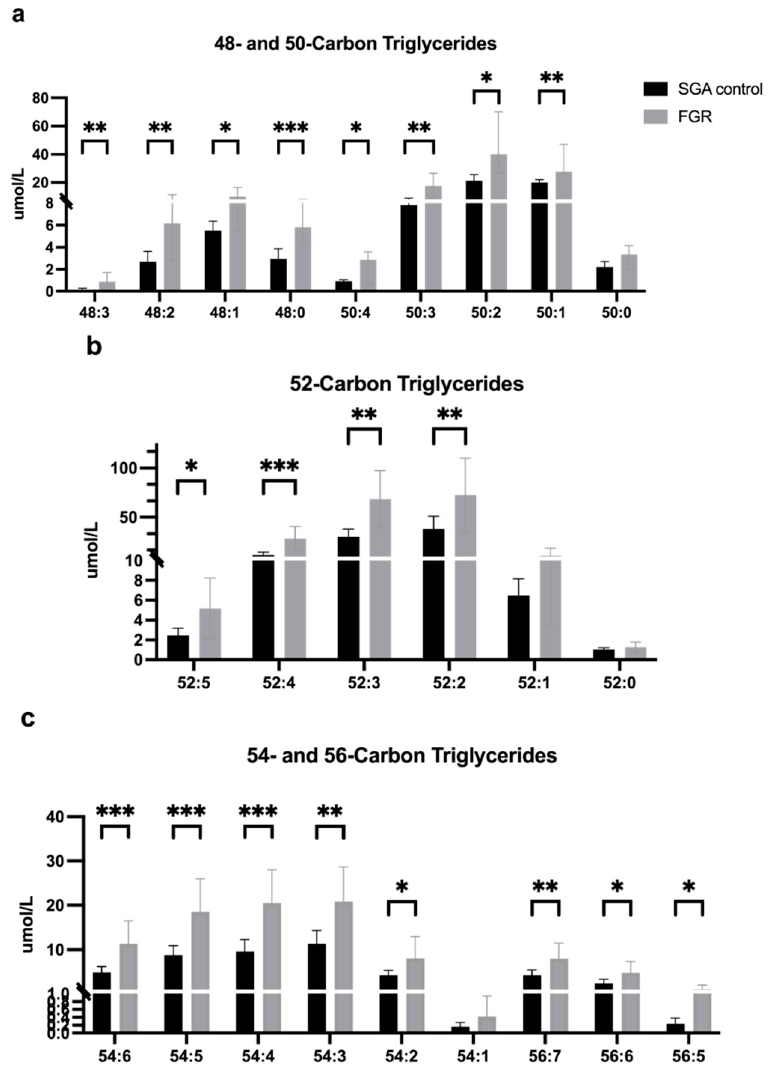
Figure 1. Triglyceride concentrations ( µ mol/L) in umbilical vein plasma. SGA control (n = 12) and FGR (n = 7) umbilical vein plasma concentrations of triglyceride molecules containing: ( a ) 48 and 50 carbon atoms; ( b ) 52 carbon atoms; and ( c ) 54 and 56 carbon atoms. Concentrations are expressed as median ± IQR for non-normally distributed data ( a ) or mean ± 95% CI for normally distributed data ( b , c ) in μ mol/L. * p < 0.05; ** p < 0.01; *** p < 0.001. Abbreviations: SGA, small for gestational age; FGR, fetal growth restriction; IQR, interquartile range; CI, confidence interval.